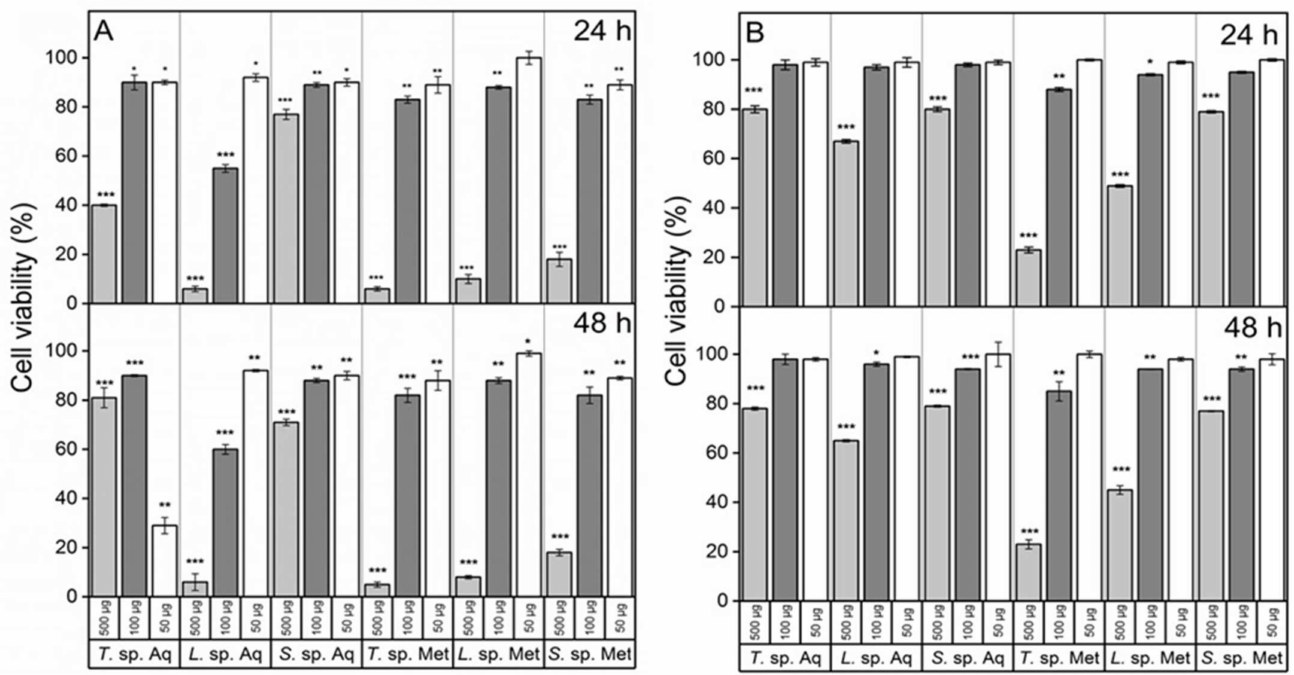
Figure 3. Cell viability test. SH-SY5Y ( A ) and HBEC ( B ) cells exposed for 24 and 48 h to increasing concentrations (50, 100, 500 µ g) of aqueous (Aq) or methanol (Met) fungal extracts of Trametes sp. S2.OA.C_F6 ( T . sp.), Lenzites sp. S3.OA.B_F6 ( L . sp.) and Sistotrema sp. S1.OA.C_F2 ( S . sp.). Results were expressed as a percentage of the corresponding untreated cultures. Error bars indicate the standard error of three independent experiments carried out in triplicate. Asterisks indicate statistically significant differences: *, p < 0.05; **, p < 0.01; ***, p <